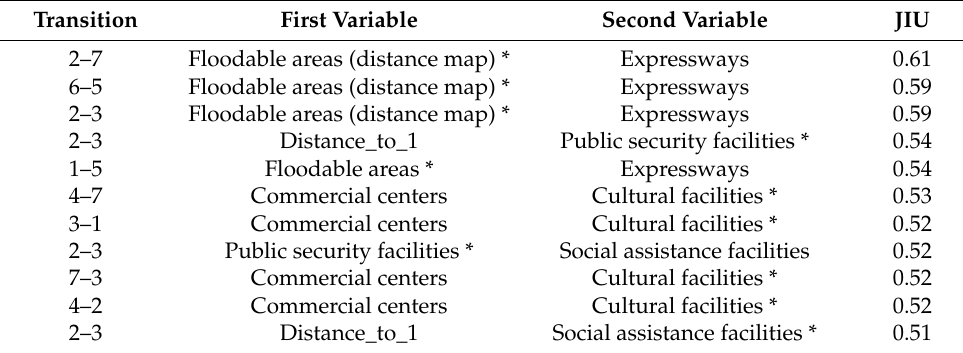
Table 4. Spatial dependence between variables (JIU > 0.50).